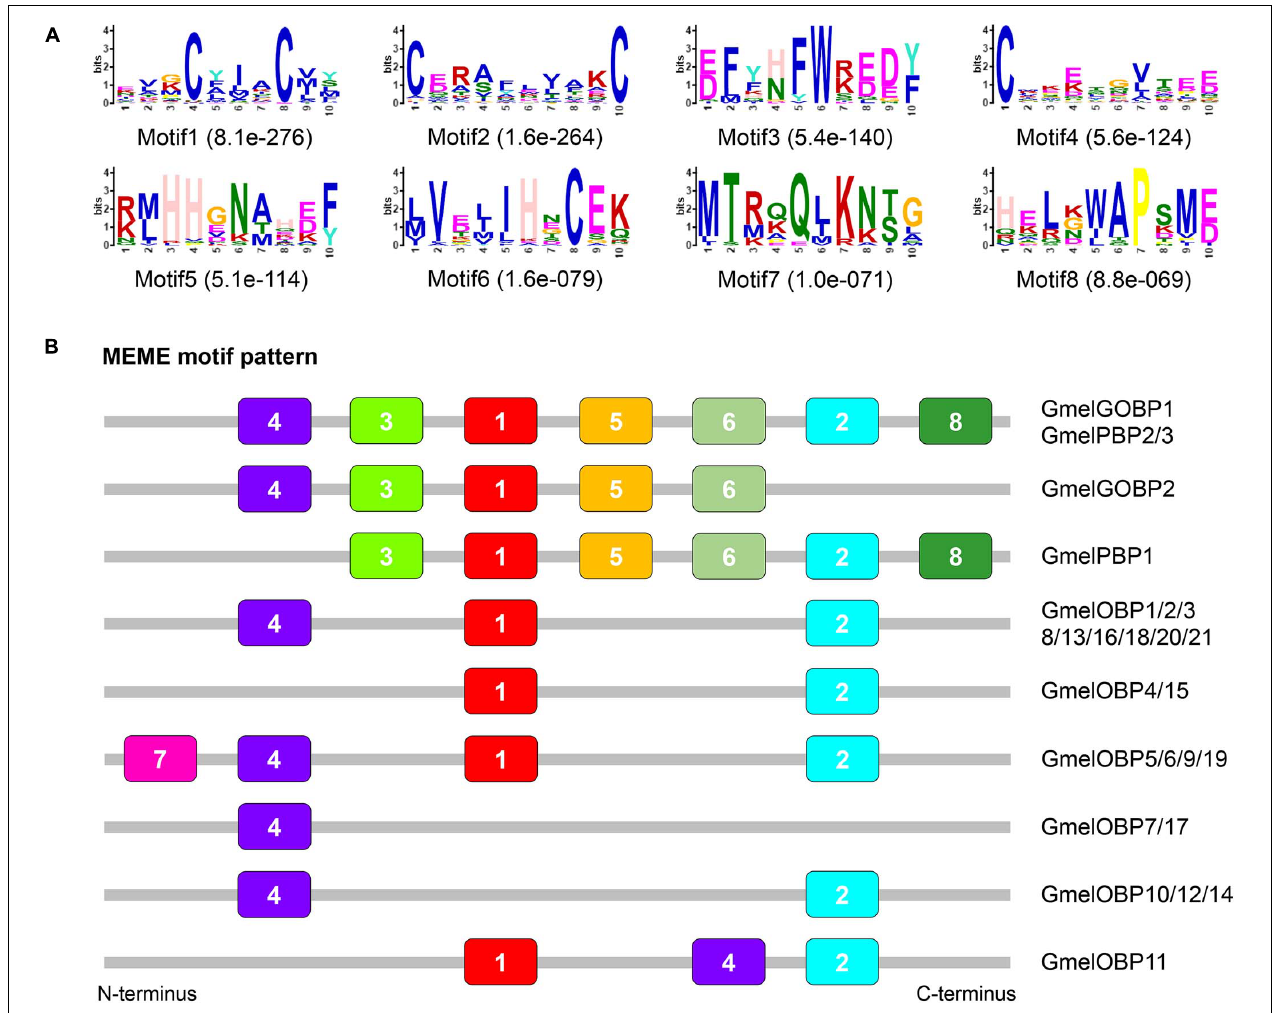
FIGURE 3 | Motif pattern analysis of G. mellonella OBPs. (A) The discovered eight motifs (motif1–8) in GmelOBP proteins and their homologs from other lepidopterans. The number in the parentheses indicated the expect-value ( e -value) of each motif calculated by MEME program. (B) Locations of each motif in the protein sequences. The numbers in the colored boxes correspond to the numbered motifs in (A) . The protein sequences of the OBPs used are listed in Supplementary Table 2 .